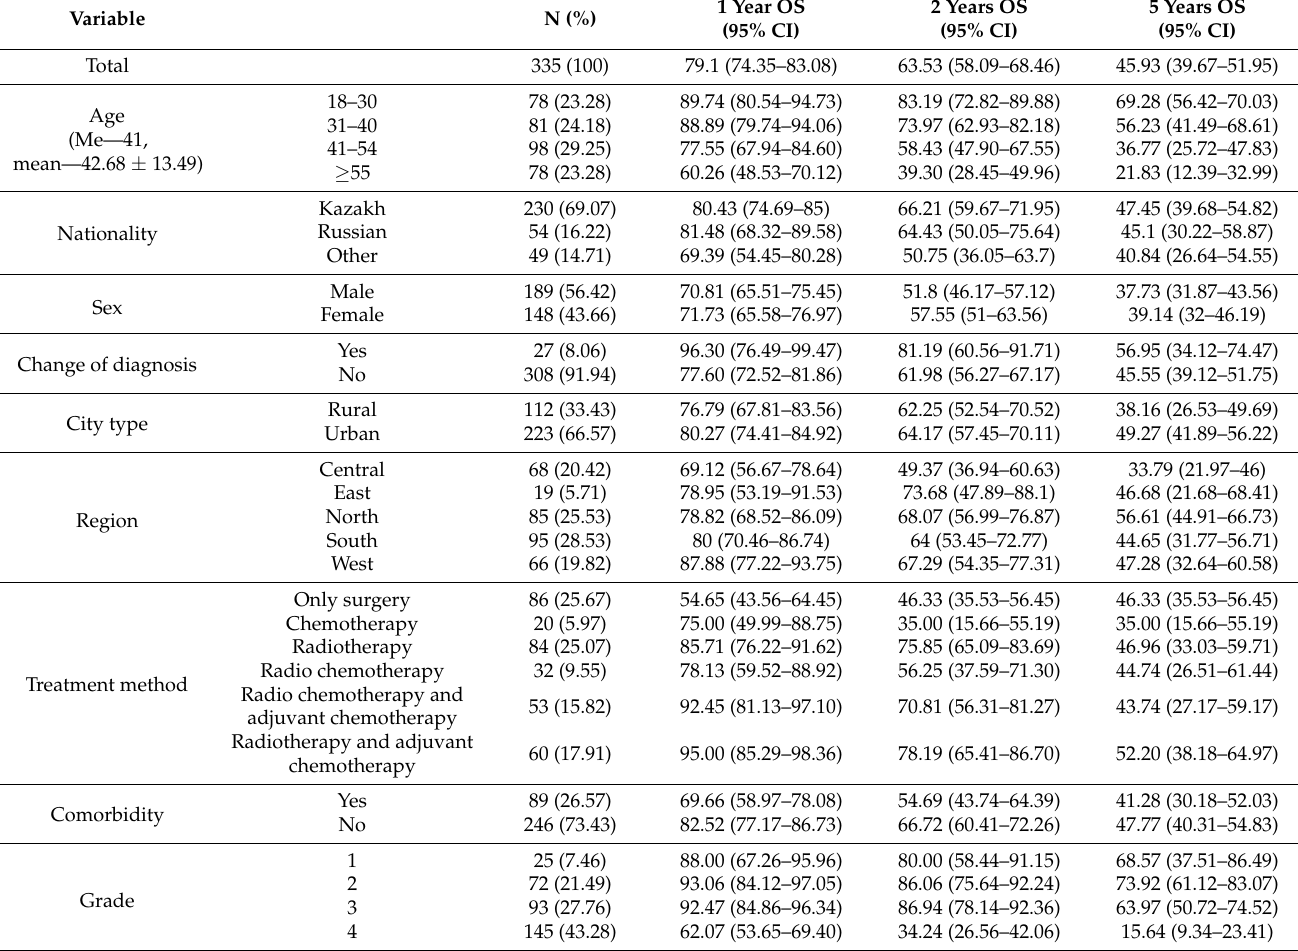
Table 2. Demographic and clinical characteristics of patients and their survival.